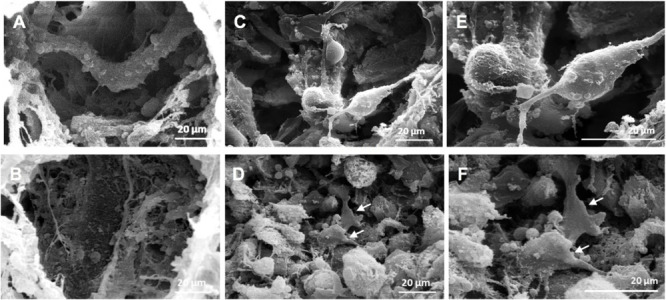
SEM micrographs of MHA/Coll structure and cells morphology. SEM micrographs of MHA/Coll architecture under G condition (A) and MHA/Coll after MG exposure (B) (1000×). Induced hBM-MSCs morphology in the center of the scaffold surface after 21 days under G condition (C) and simulated MG condition (D). Induced hBM-MSCs connected together and attached onto the fibers of the scaffold under G condition (E) and after MG exposure (F) (2000×). White arrows indicate changes in cell morphology induced by MG exposure.